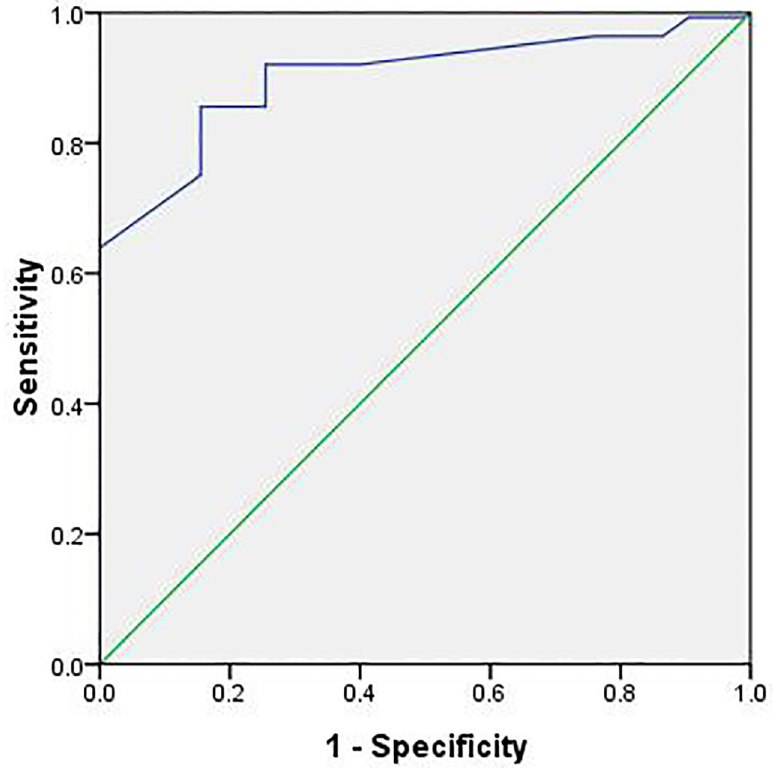
Fig 3. ROC analysis of the CT score for prediction of mortality. N = 27; AUC =